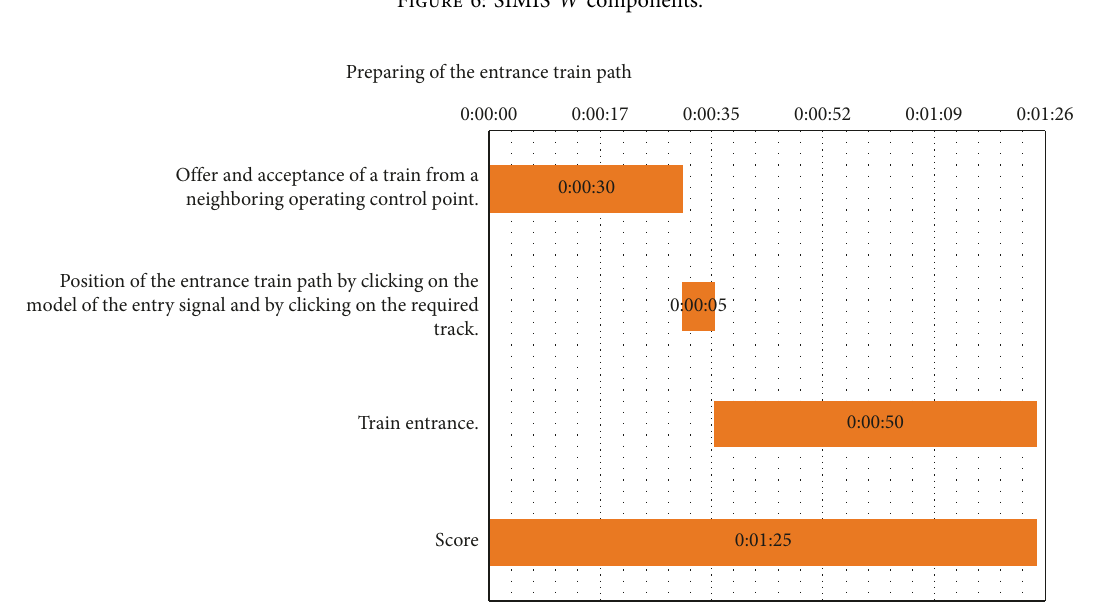
Figure 6: SIMIS W components.